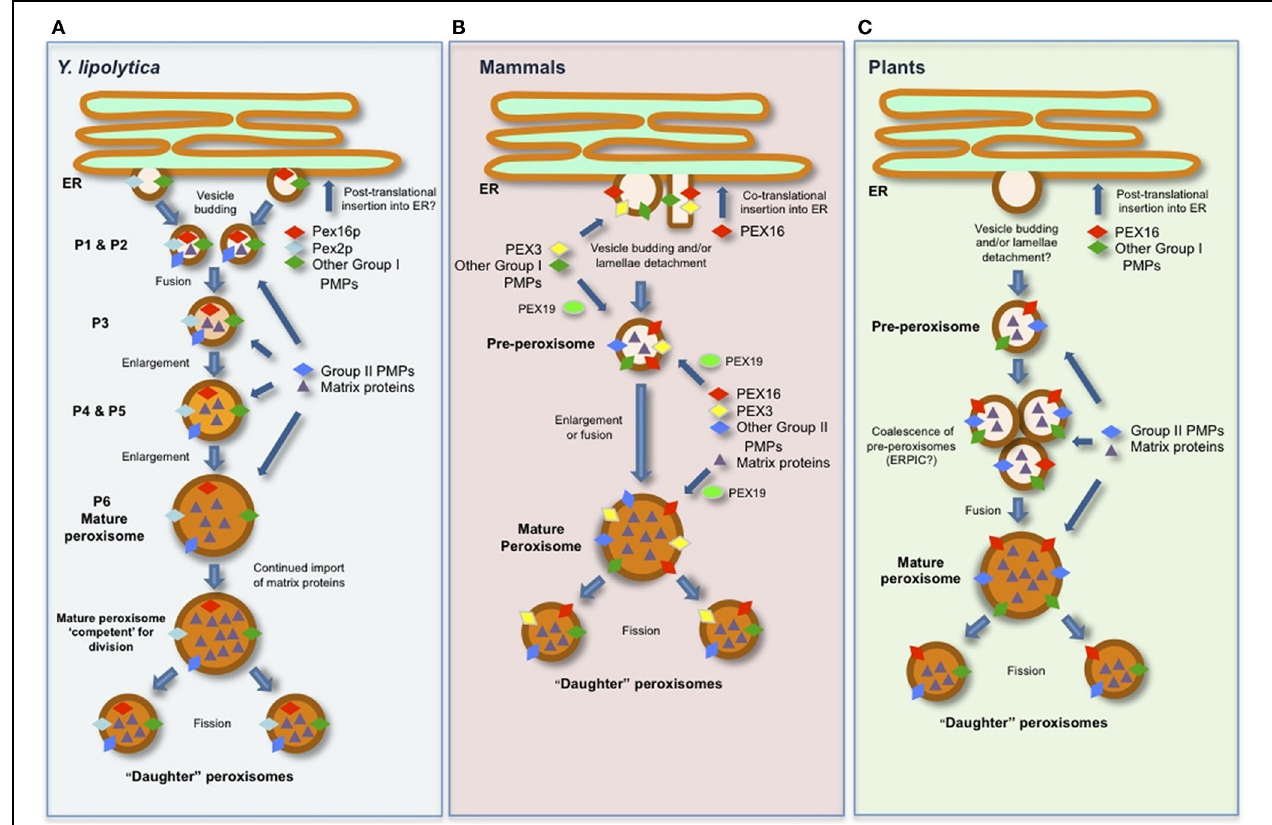
FIGURE 1 | Schematic representations of generalized models for the biogenesis of peroxisomes and the role(s) of PEX16 in (A) Y. lipolytica , (B) mammals (human), and (C) plants ( Arabidopsis ). See text for details and references.